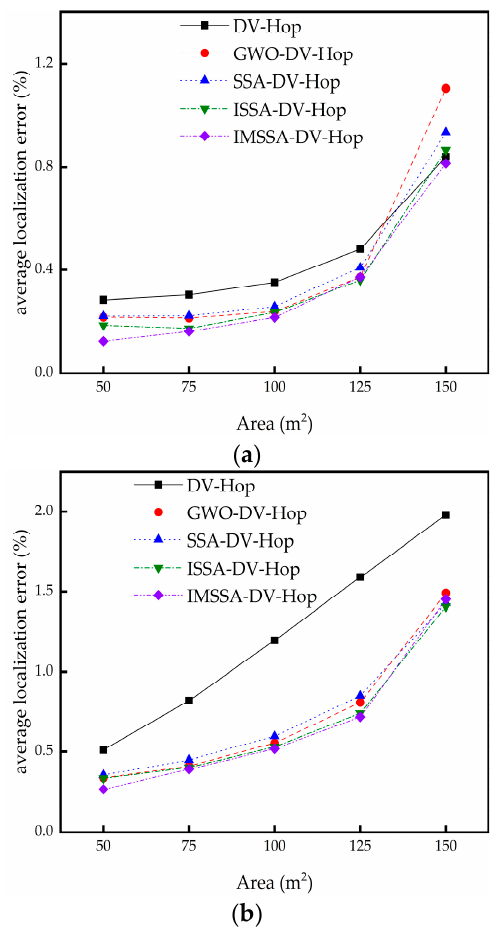
Figure 10. Localization error diagrams for different Area: ( a ) square random topology; ( b ) C-shaped random topology. Table 8. Localization error in different Area in square random topology.